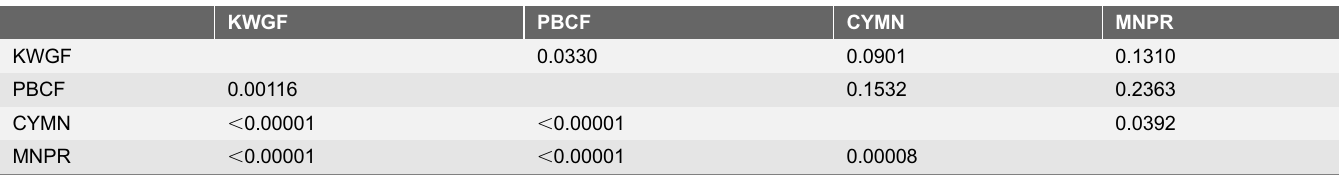
Table 1. Pairwise comparisons for 740 base pair control region haplotype frequencies for hawksbill turtle juvenile foraging aggregations in the Greater Caribbean region.